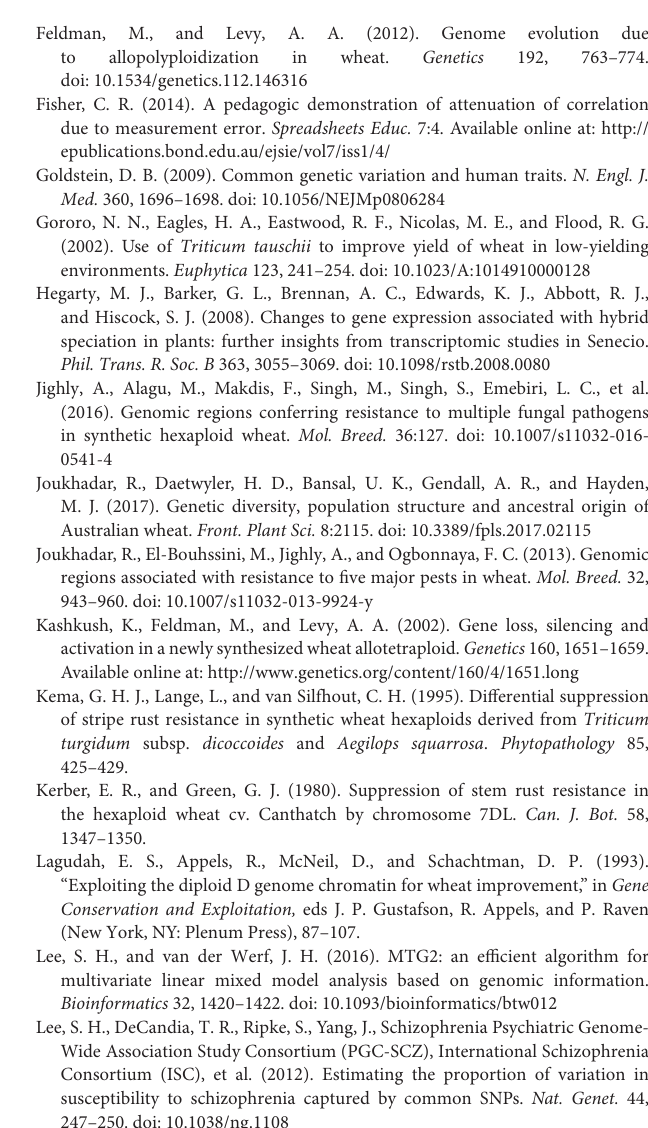
Figure S1 | Percentage of individual chromosome contribution to the additive variance for each trait as function to chromosome size. Colors represents different subgenomes; red: “A” subgenome chromosomes; Green: “B” subgenome chromosomes; and Purple: “D” subgenome chromosomes. The gray line represents the correlation for all 21 chromosomes.